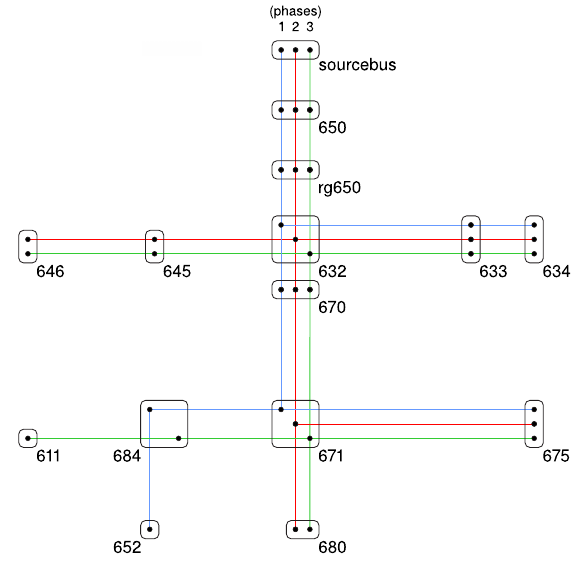
Figure 3. Network